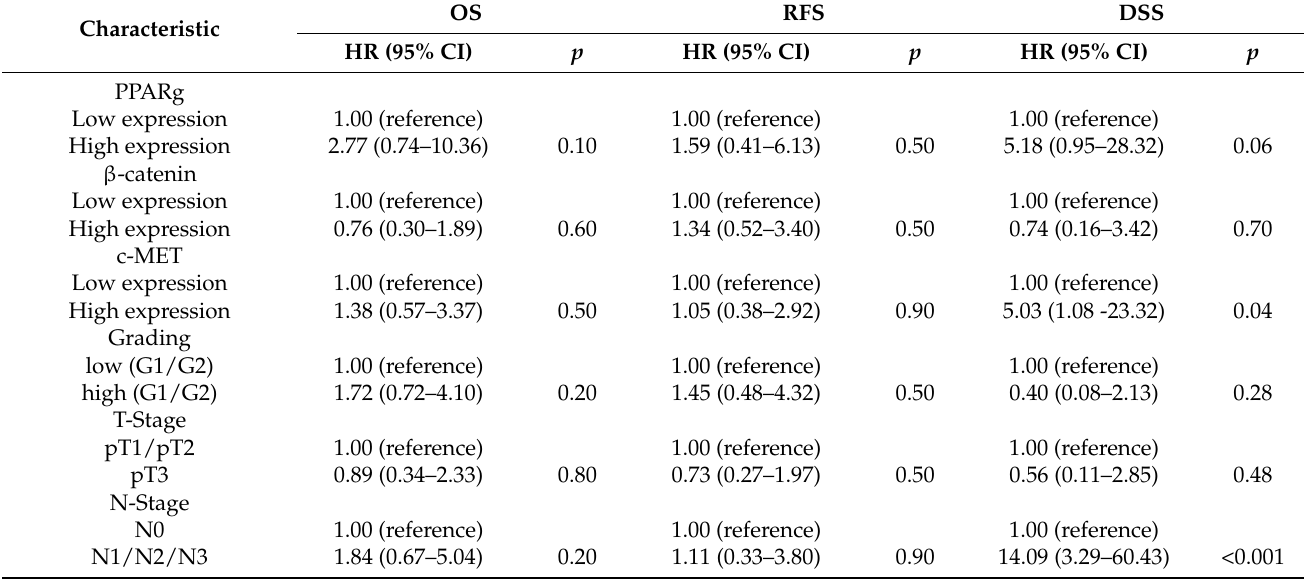
Table 2. Multivariate COX regression analysis of OS, DSS, and